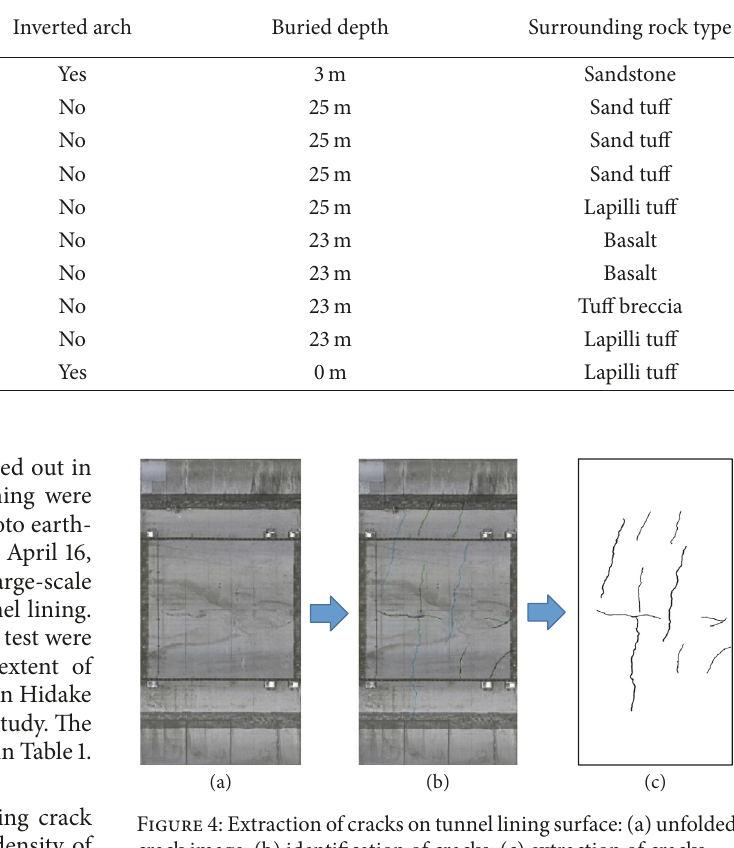
Table 1: The basic conditions of the concrete lining for ten studied spans.